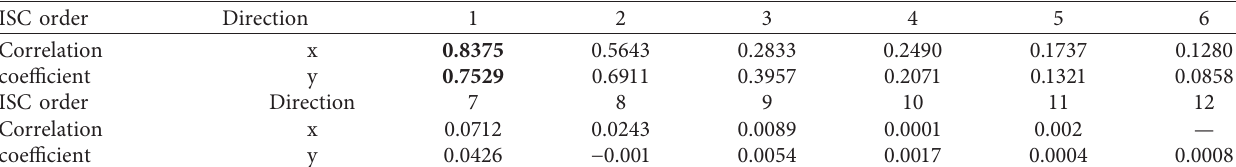
Table 4: Correlation coefficient of ISCs of each order under outer race fault condition.